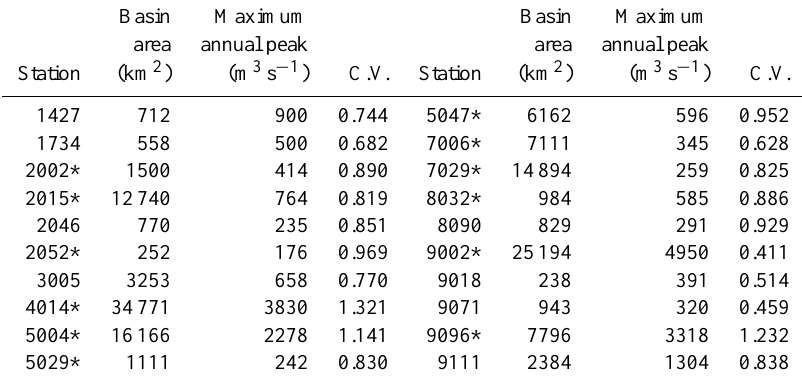
* Indicate stations with upstream dams. C.V.: coefficient of variation.